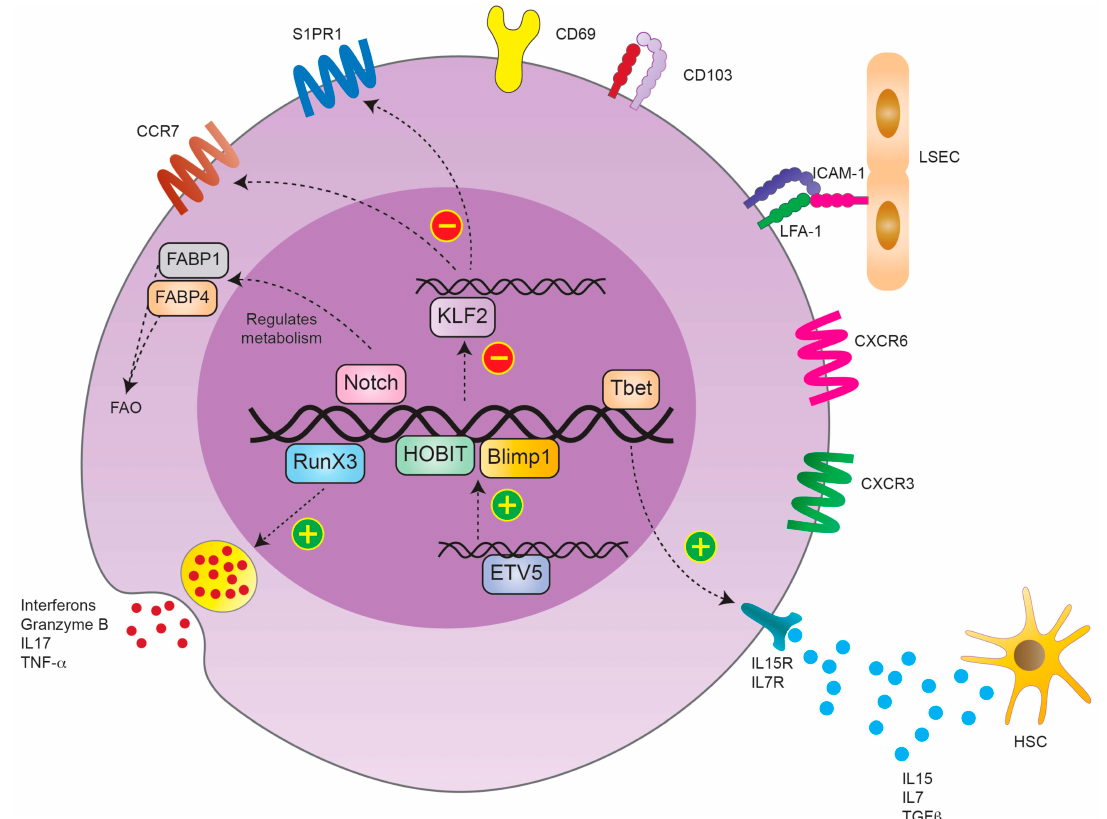
Figure 1. To convey hepatic infiltration, memory T cells express high levels of liver-specific homing markers such as CD103, LFA-1, CXCR6 or CXCR3. Within the liver, T RM cells are exposed to a